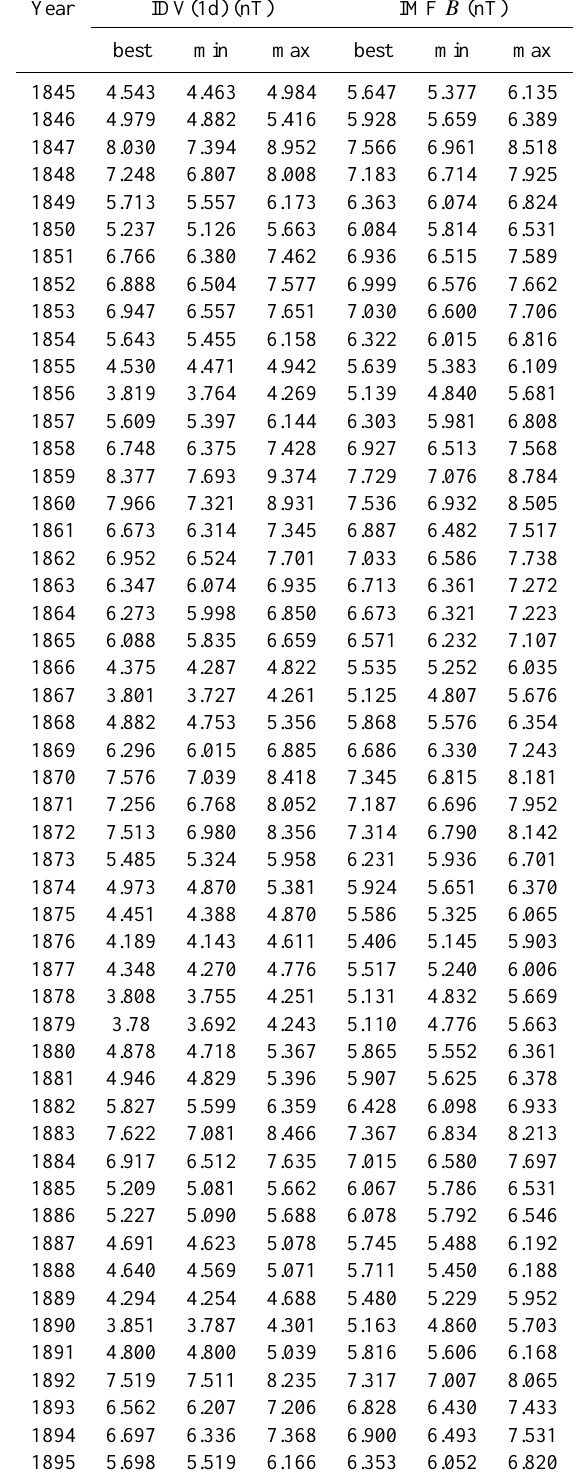
Table 2. Annual IDV(1d) composite and derived IMF B values with 2 σ